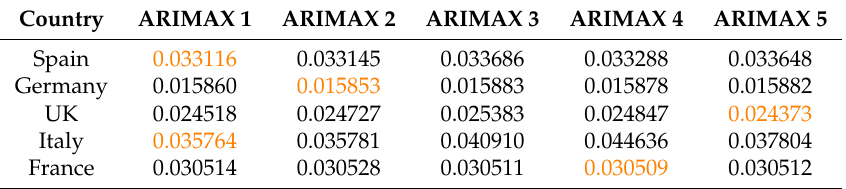
Table 12. RMSE for out-of-sample period of ARIMAX models for mean country spread difference.